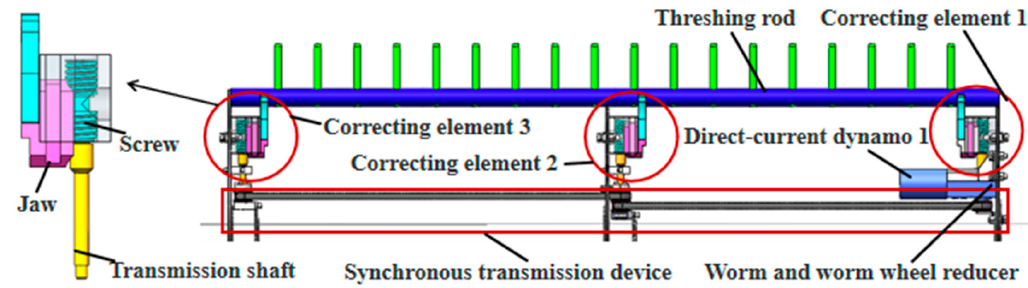
Figure 6. Schematic diagram of working principle.